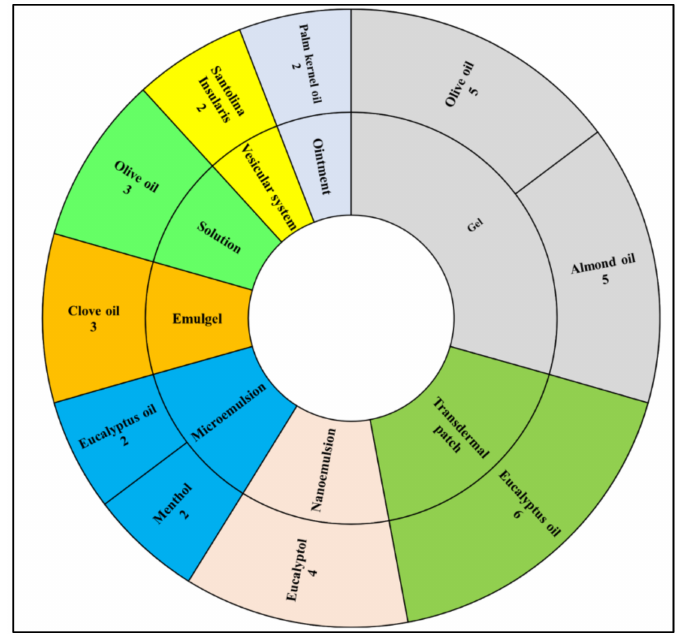
Figure 4. The most frequently used dosage forms with the most frequently used oil from all eligi- ble